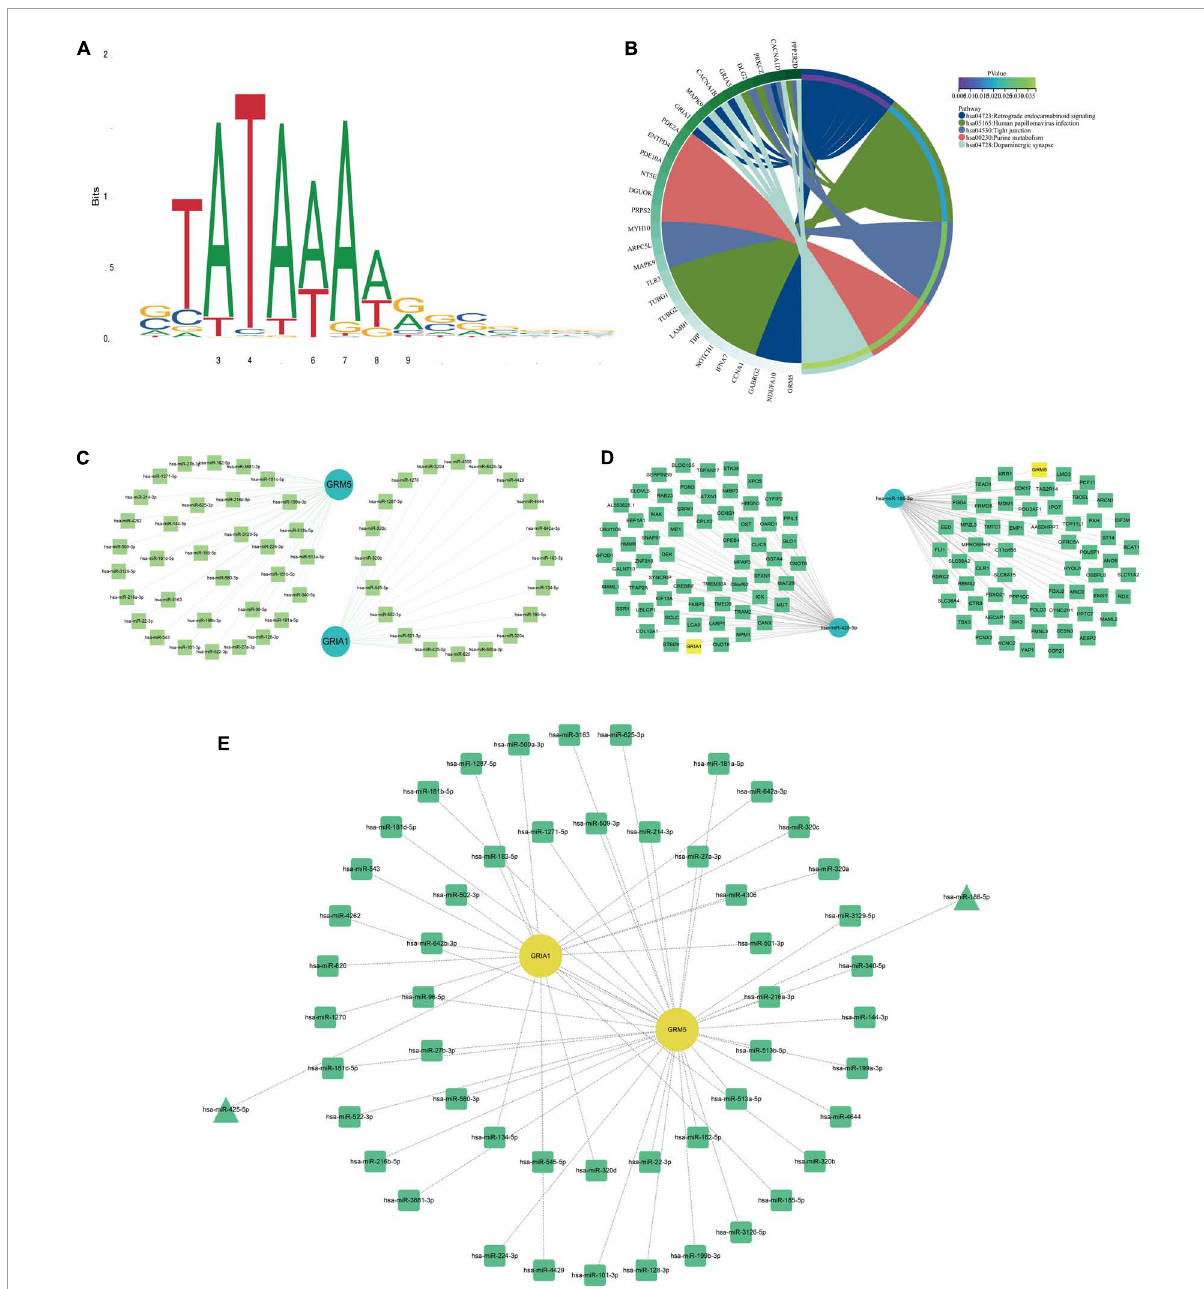
FIGURE4 Kyoto encyclopedia of genes and genomes (KEGG) pathway map, TBP binding site map, and key mRNA miRNAs prediction. (A) TBP transcription factor binding site. (B) KEGG pathway diagrams of differentially expressed genes (DEGs). (C) The miRNAs to GRM5 and GRIA1 bind are predicted. In the network, thin lines represent sequence matches, green balls represent miRNAs and blue balls represent mRNA. (D) The mRNA binding to hsa-miR-425-5p and hsa-miR-186-5p was predicted. In the network, thin lines represent sequence matching, green spheres represent mRNA, and blue spheres represent miRNA. (E) The network diagram of Hub gene and miRNA. The yellow ball represents the gene, the green represents the miRNA, and the green triangle is the miRNA we finally screened.